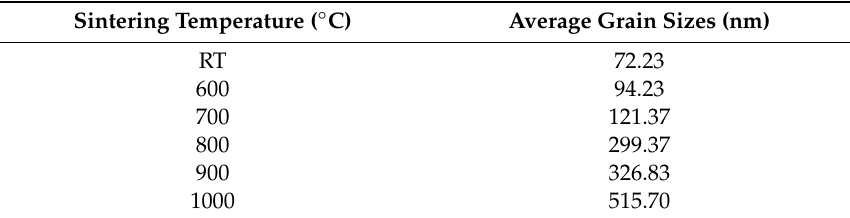
Table 1. Average grain sizes of ZnO-SiO 2 at di ff erent sintering temperatures.